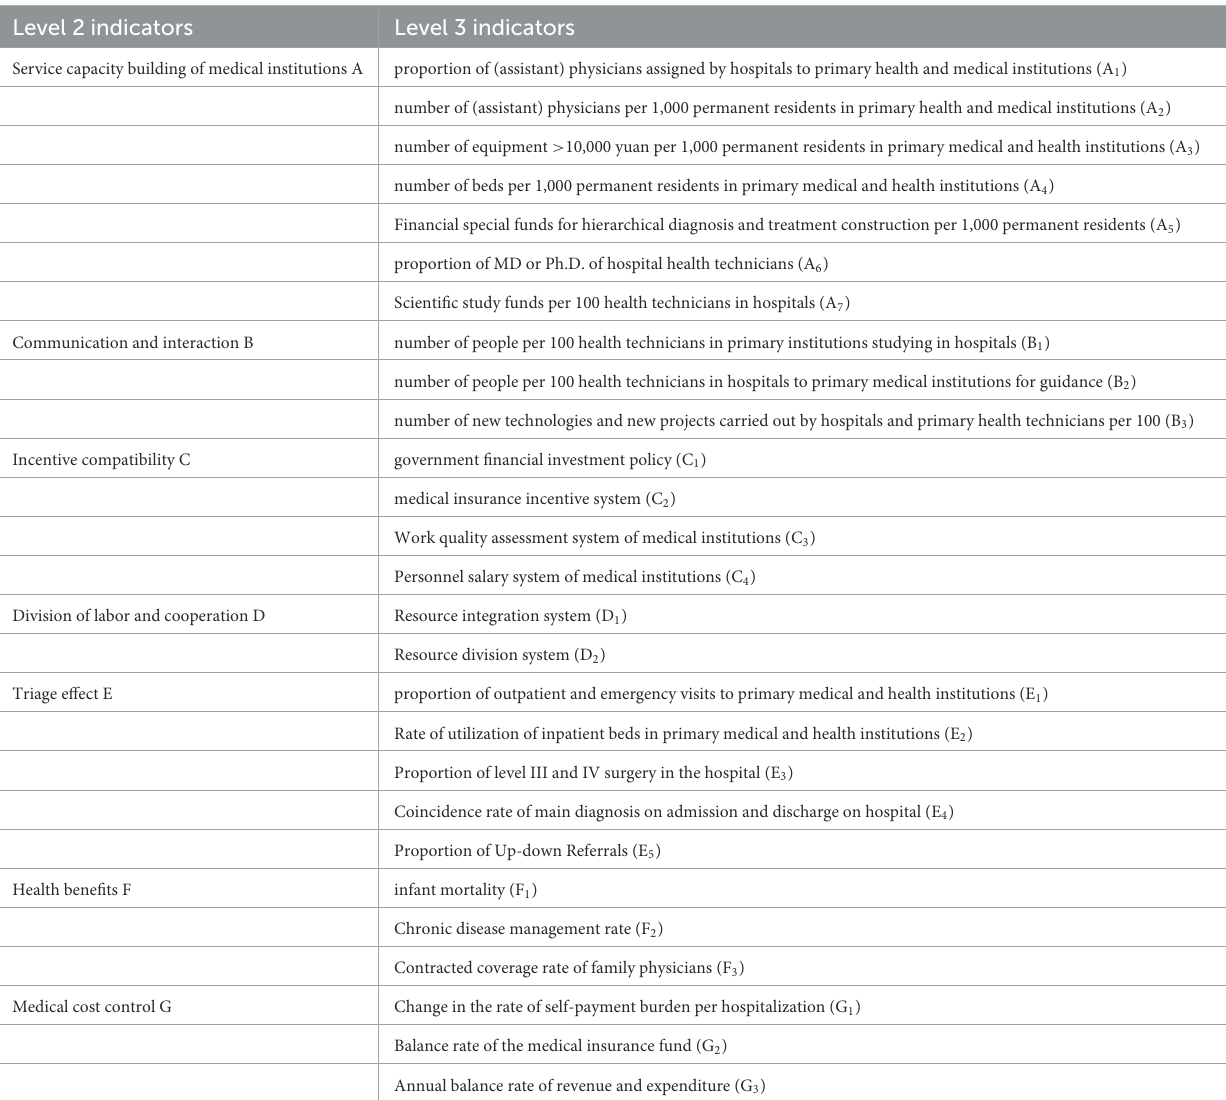
TABLE 1 Performance evaluation indicator system of the hierarchical diagnosis and treatment